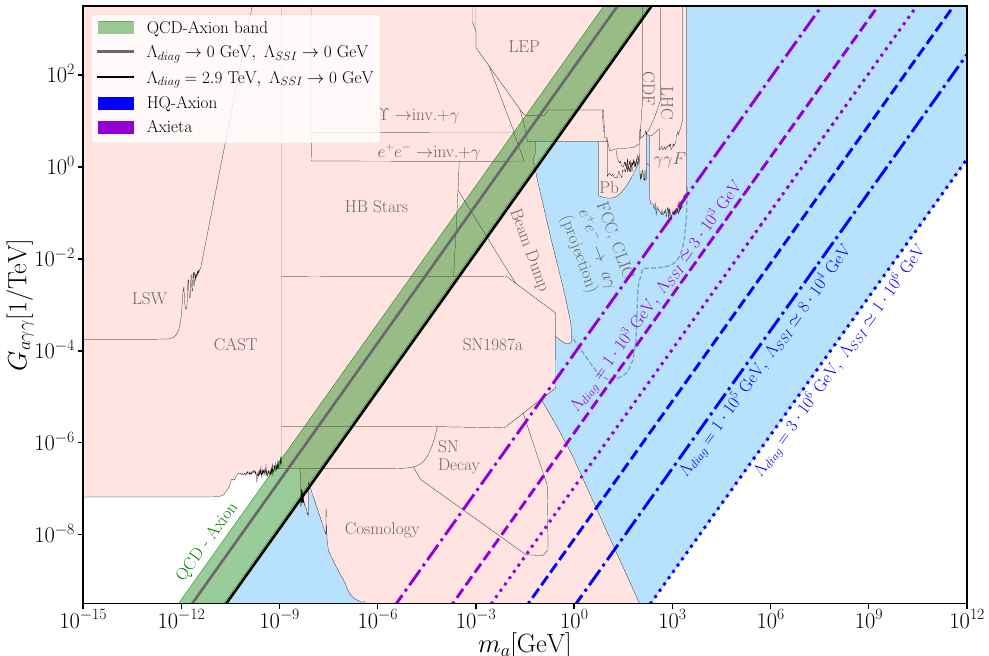
Figure 5 . Axion bands of the color unified model variant M1 in the m a vs. G aγγ plane. The band in green shows canonical DFSZ- and KSVZ-models, while the pink shaded regions show the current experimental bounds on axions and ALPs [58–69], and we include a contour from a future projection of CLIC sensitivity from ref. [70]. The blue shaded region shows the possible parameter space for the new HQ-axion a and the axieta η d enhanced by SSI effects, where lines in blue and violet show chosen models with the corresponding scales Λ diag and Λ SSI . A lower and upper bound on the Λ diag and Λ SSI scales arises because of experimental constraints on new color gauge group extensions discussed in the main